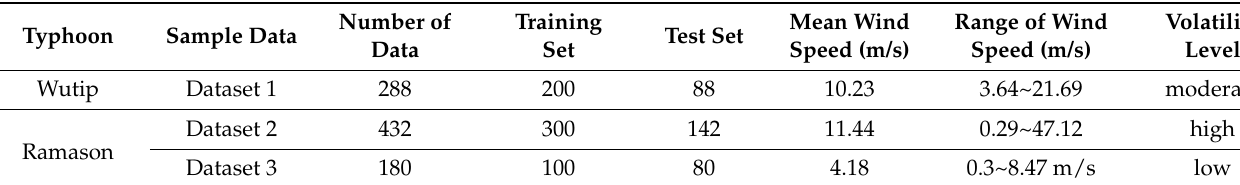
Table 1. Statistic features of datasets.